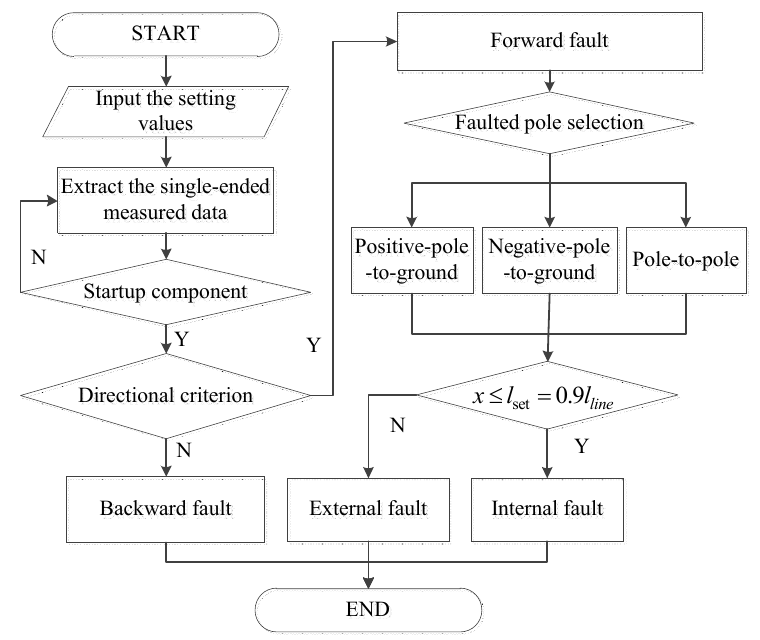
Figure 11. The flowchart of the proposed single-ended DC fault protection scheme.